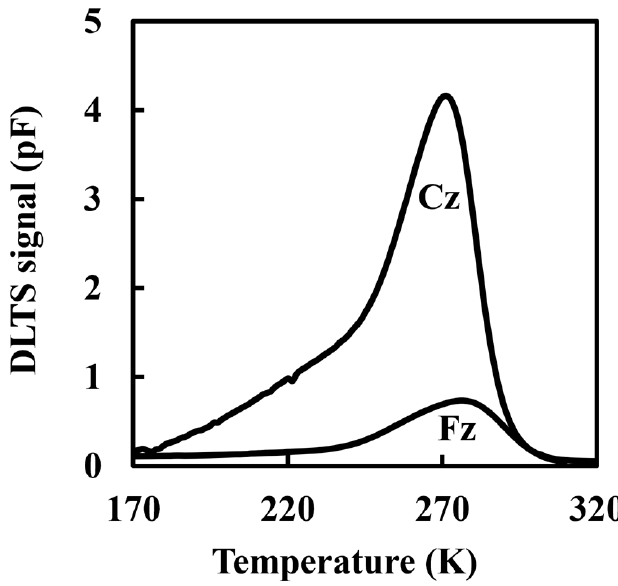
Figure 2. DLTS spectra obtained from Cz-Si and Fz-Si MOS sample processed with RPD. As well as the spectral deconvolution, the electrical defect properties used as search parameters were estimated in the Bayesian optimization. The obtained energy levels and capture cross-sections are summarized in Table 1. Because these defect properties are almost the same as those of the Cz-Si crystal, the same types of defects were induced by RPD, regardless of the crystal type. The E1 defect has a mid-gap energy level and approximately 10 − 15 cm 2 capture cross-sections. This suggests that these defects might be recombination centers [27,28]. Because the types of defects are the same and their concentrations are different, it is suggested that the oxygen concentration in the Si crystal related to the number of induced defects. Table 1. Estimated electrical property of RPD-induced defects, where Ec − Et is the defect level from conduction band edge Ec, and σ is the capture cross-section for majority carriers.